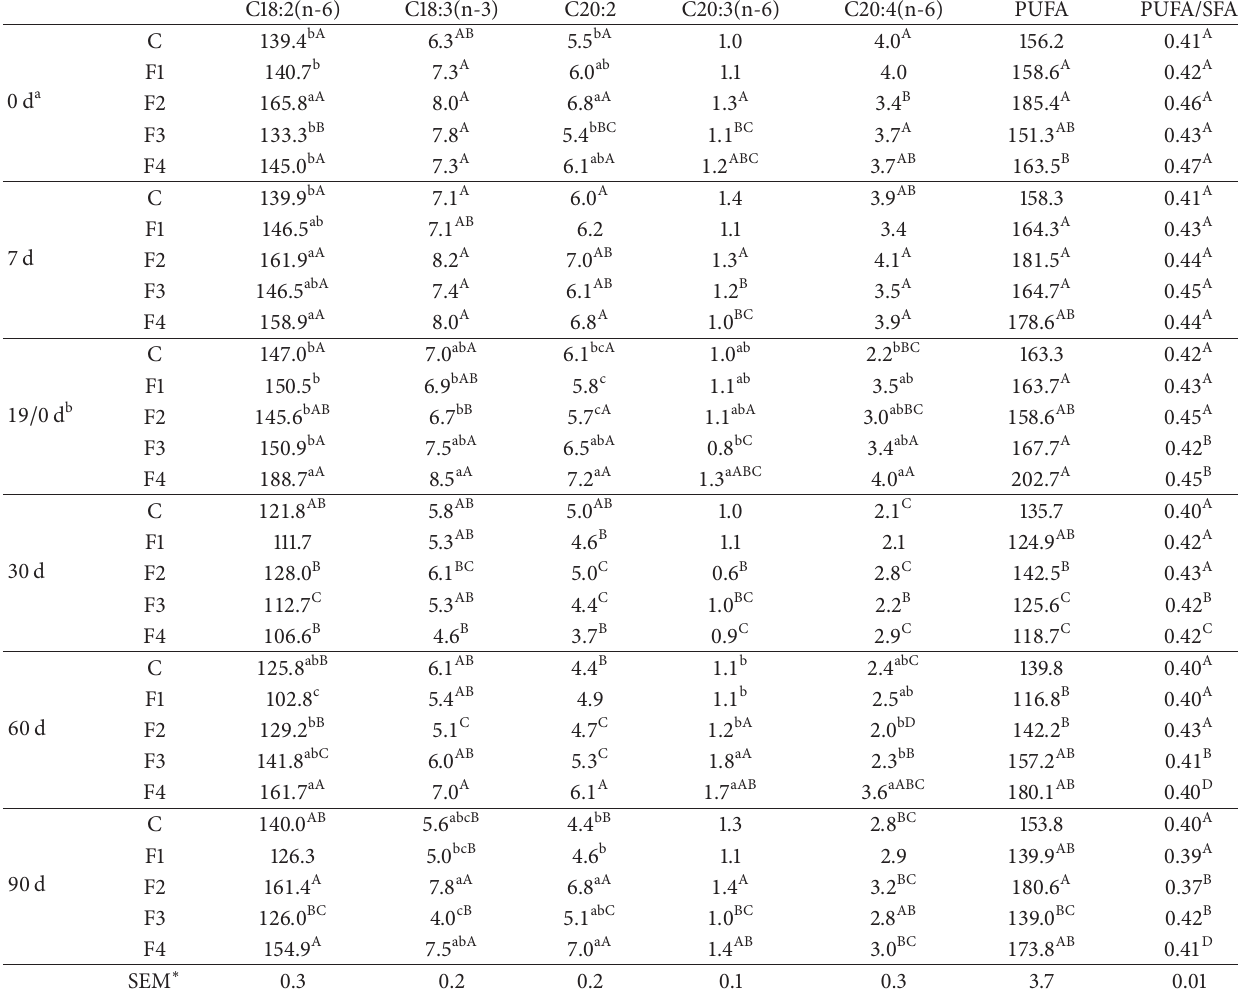
Table 4: Content of polyunsaturated fatty acids (PUFA) in the lipid fraction (mg/g fat) during curing process and storage of salamis with NaCl reduced or replaced by KCl and/or CaCl 2